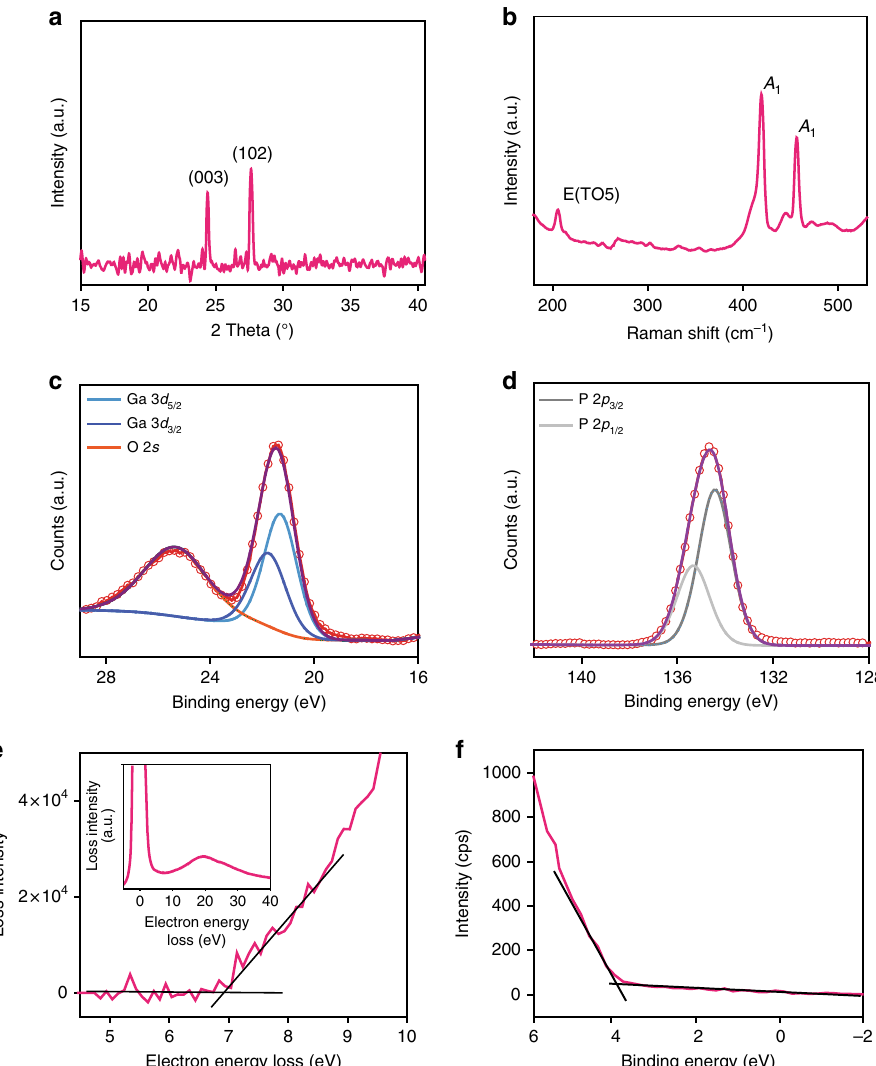
Fig. 3 Material characterisations and electronic band properties of 2D GaPO 4 . a XRD and b Raman spectra of the synthesised GaPO 4 (thick nanosheets). XPS results of c Ga 3 d and d phosphorous 2 p regions of the synthesised GaPO 4 . e Enlarged view of EELS for the estimation of the fundamental bandgap and the extended EELS spectrum (inset). f XPS valence band analysis of GaPO